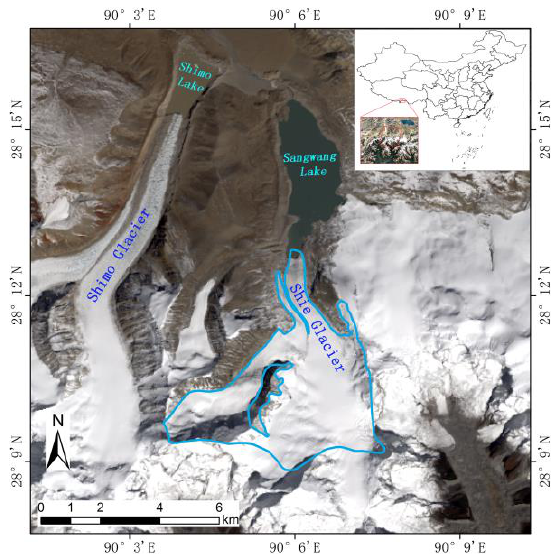
Figure 1. Landsat-8 image of the study area and the extent of Shie glacier in the second glacier inventory of China.